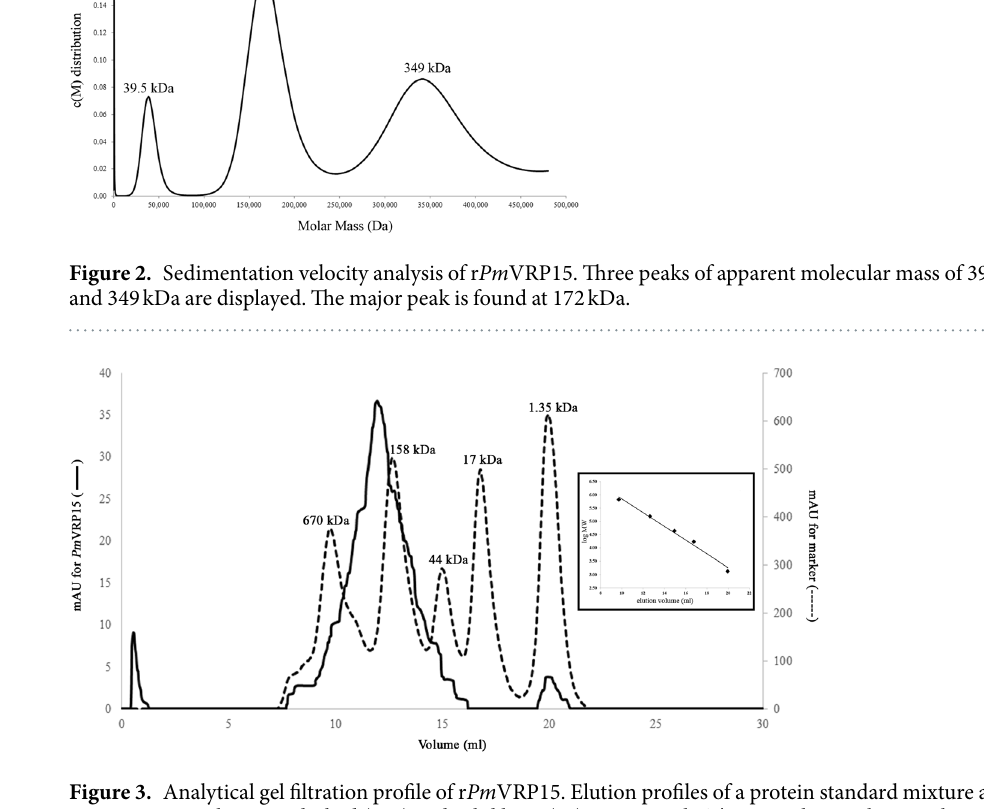
Figure 3. Analytical gel filtration profile of r Pm VRP15. Elution profiles of a protein standard mixture and r Pm VRP15 are shown in dashed (----) and solid lines (—), respectively. The inset shows a linear relationship between log MW and elution volume.